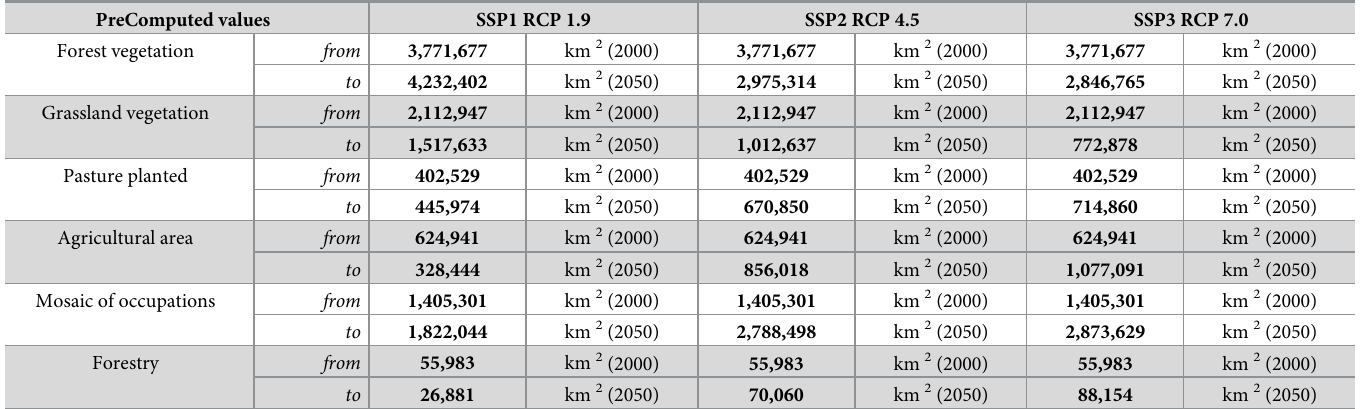
Table 4. Land demand parameters. PreComputed